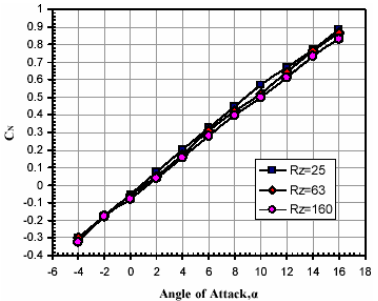
Fig. 10 Comparison of pitching moment Coefficient at Mach 0.3